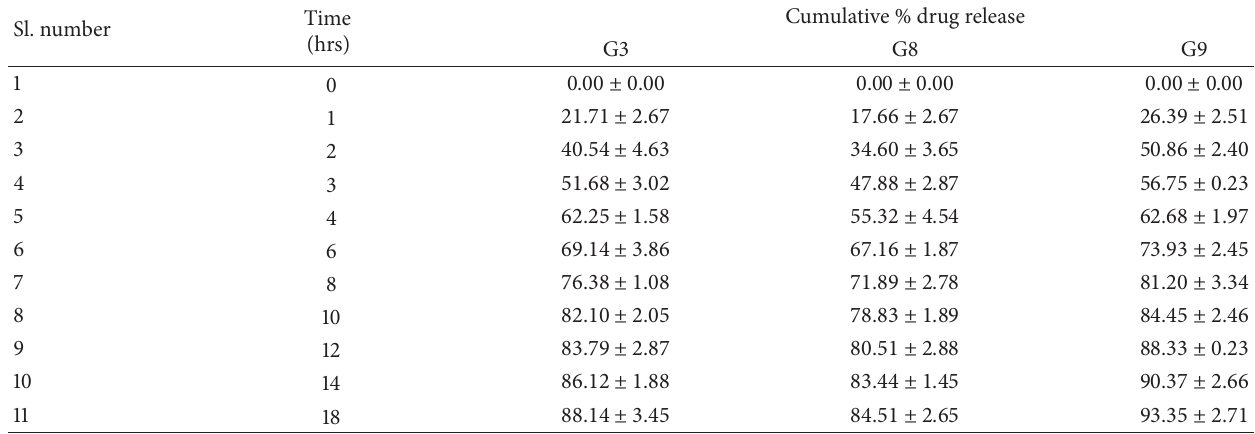
Table 6: Effect of solvent ratio on drug release in 0.1N HCl.